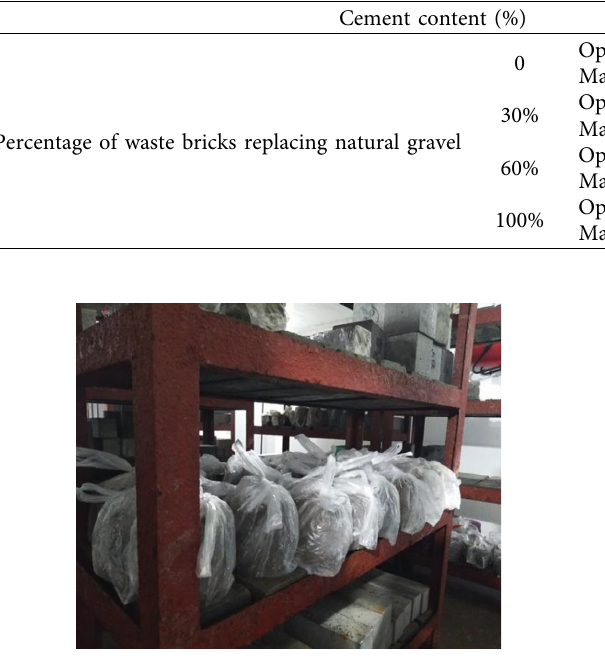
Table 5: Compaction test results.